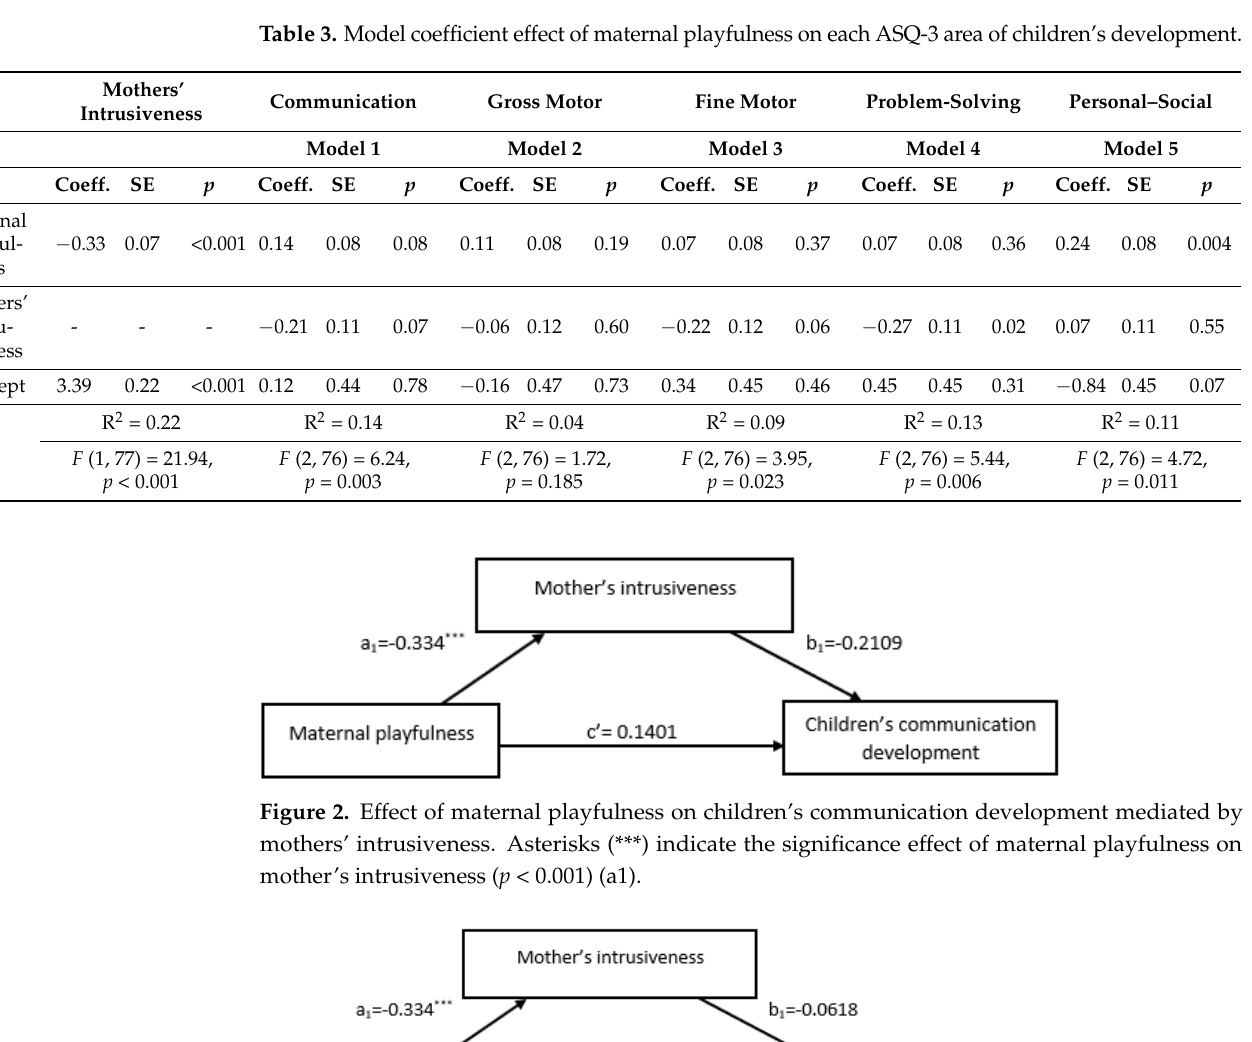
Table 3. Model coefficient effect of maternal playfulness on each ASQ-3 area of children’s development.